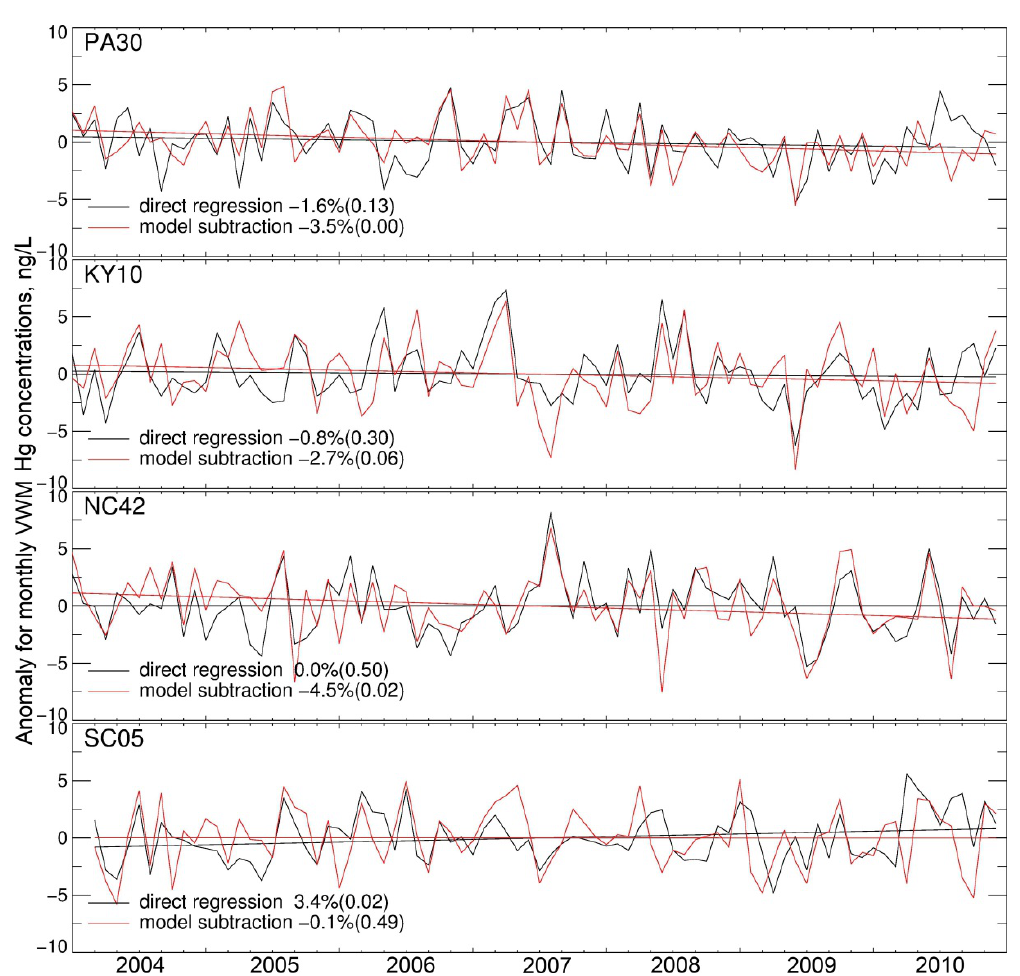
Figure 3. Monthly deseasonalized time series of VWM Hg concentrations in precipitation for the direct regression method (black) and the model subtraction method (red). Four MDN sites are shown, from top to bottom: Erie site, Pennsylvania (PA30); Mammoth Cave National Park-Houchin Meadow, Kentucky (KY10); Pettigrew State Park, North Carolina (NC42) and Cape Romain National Wildlife Refuge, South Carolina (SC05). See Figure S1 for the location of these sites. The resulting trends, in % yr − 1 and p-scores (in parenthesis) are indicated in the